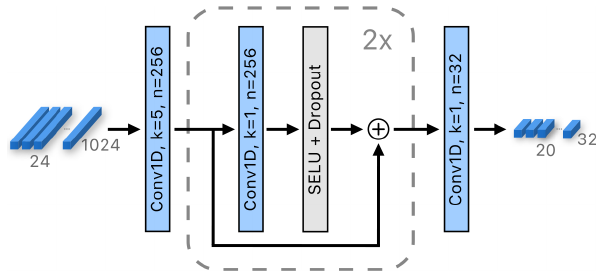
Figure 5. The second stage of the Atmospheric encoder. Features from all time points and both wind and pressure are processed with a 1D convolution, followed by two blocks with residual connections. The last convolution reduces feature dimensionality. The variables k and n denote the kernel size and the number of output channels, respectively.